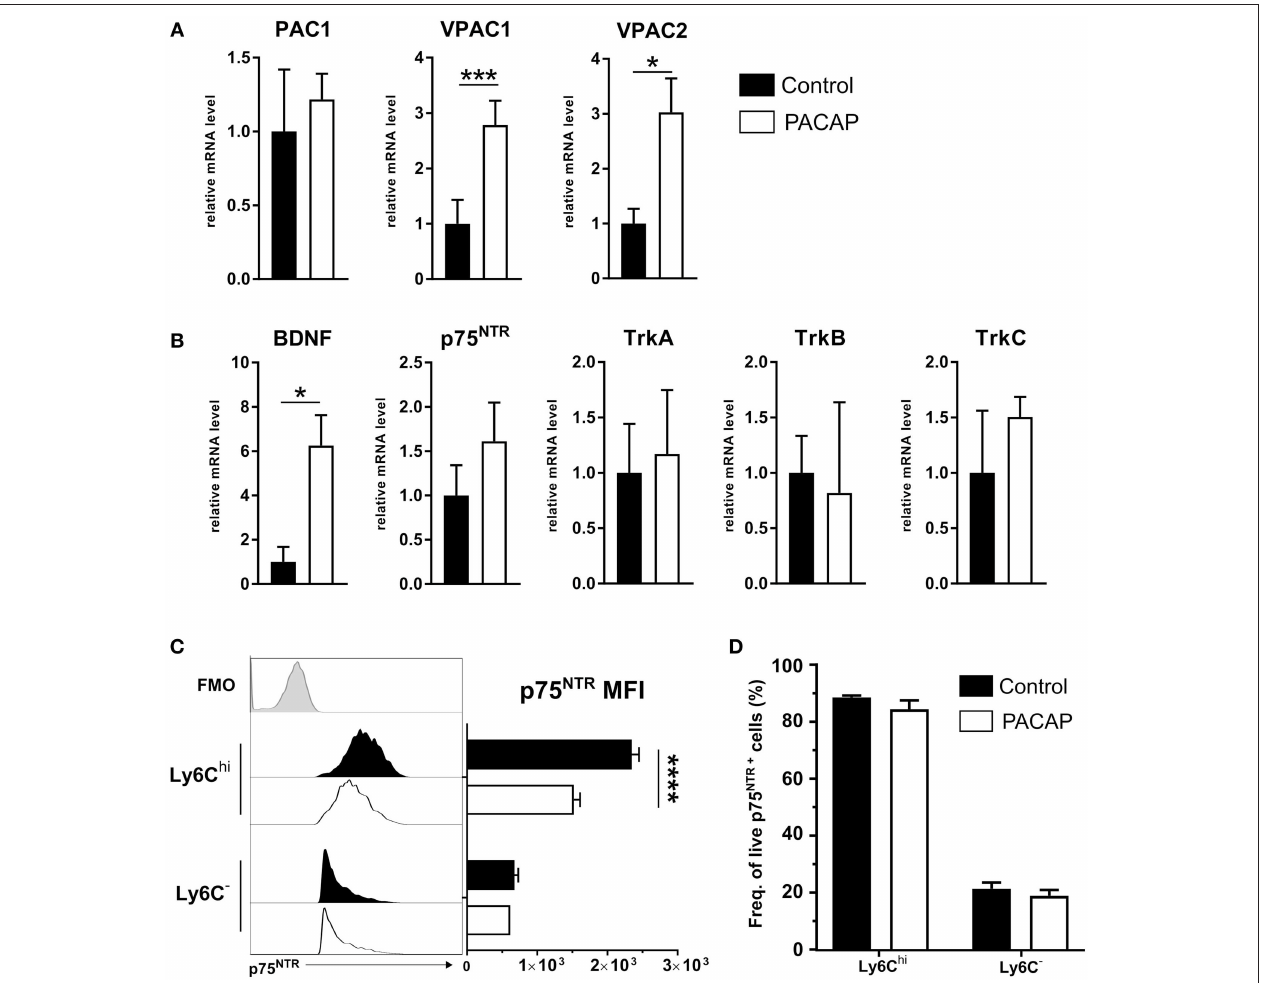
FIGURE 5 | Expression of PACAP receptors, BDNF and neurotrophin receptors on peritoneal cells. Gene expression of (A) PACAP receptors and (B) BDNF and neurotrophin receptors was assessed by RT-qPCR. Control (black bars) and PACAP-treated (white bars); data are expressed as mean ± SEM, * p < 0.05, *** p < 0.001 (two-tailed unpaired t -test). (C) Flow cytometric analysis of p75 NTR expression on immune cell subsets; the histograms show the FMO control (light gray-tinted), control group (black-tinted) and PACAP group (black non-tinted); bar charts present the values of MFI for p75 NTR expression. (D) Frequency of cells from parent population of living, single p75 NTR + cells. Data are presented as mean ± SEM, n = 4. **** p < 0.0001 (two-tailed unpaired t